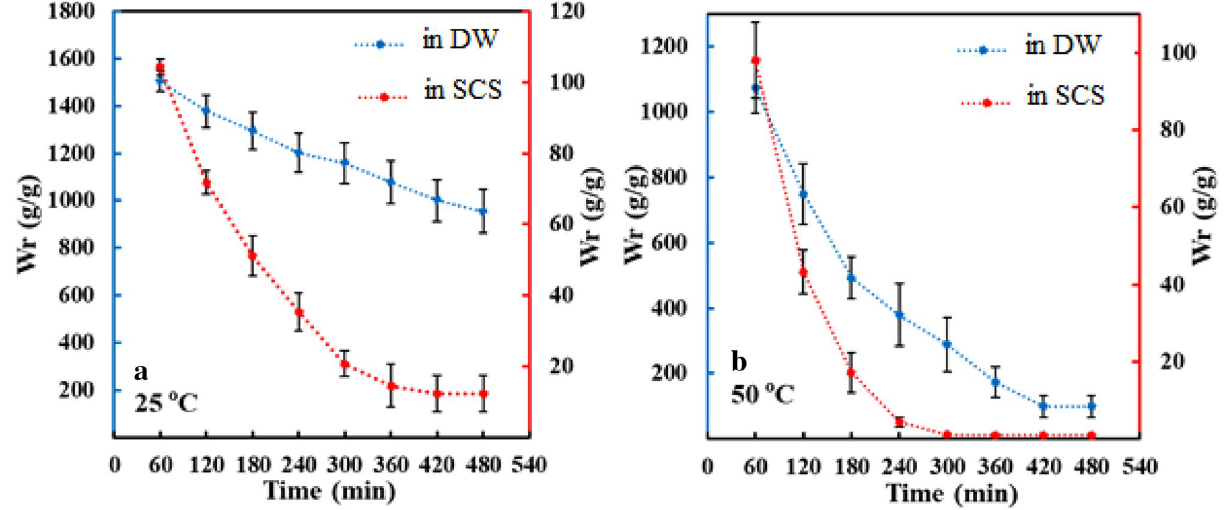
Figure 6. The water retention rate of p(AA-co-AM-co-MA) superabsorbent at ( a ) 25 °C and ( b ) 50 °C in DW (blue color) and SCS (red